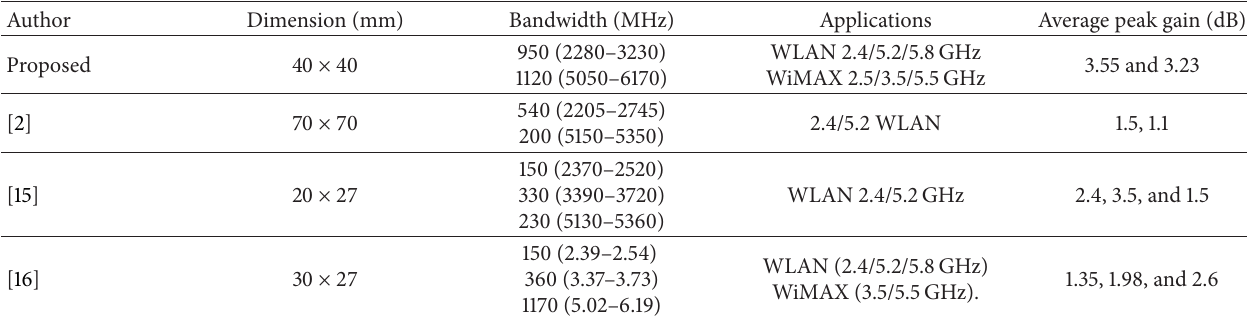
Table 2: Comparison between proposed and some existing antennas.